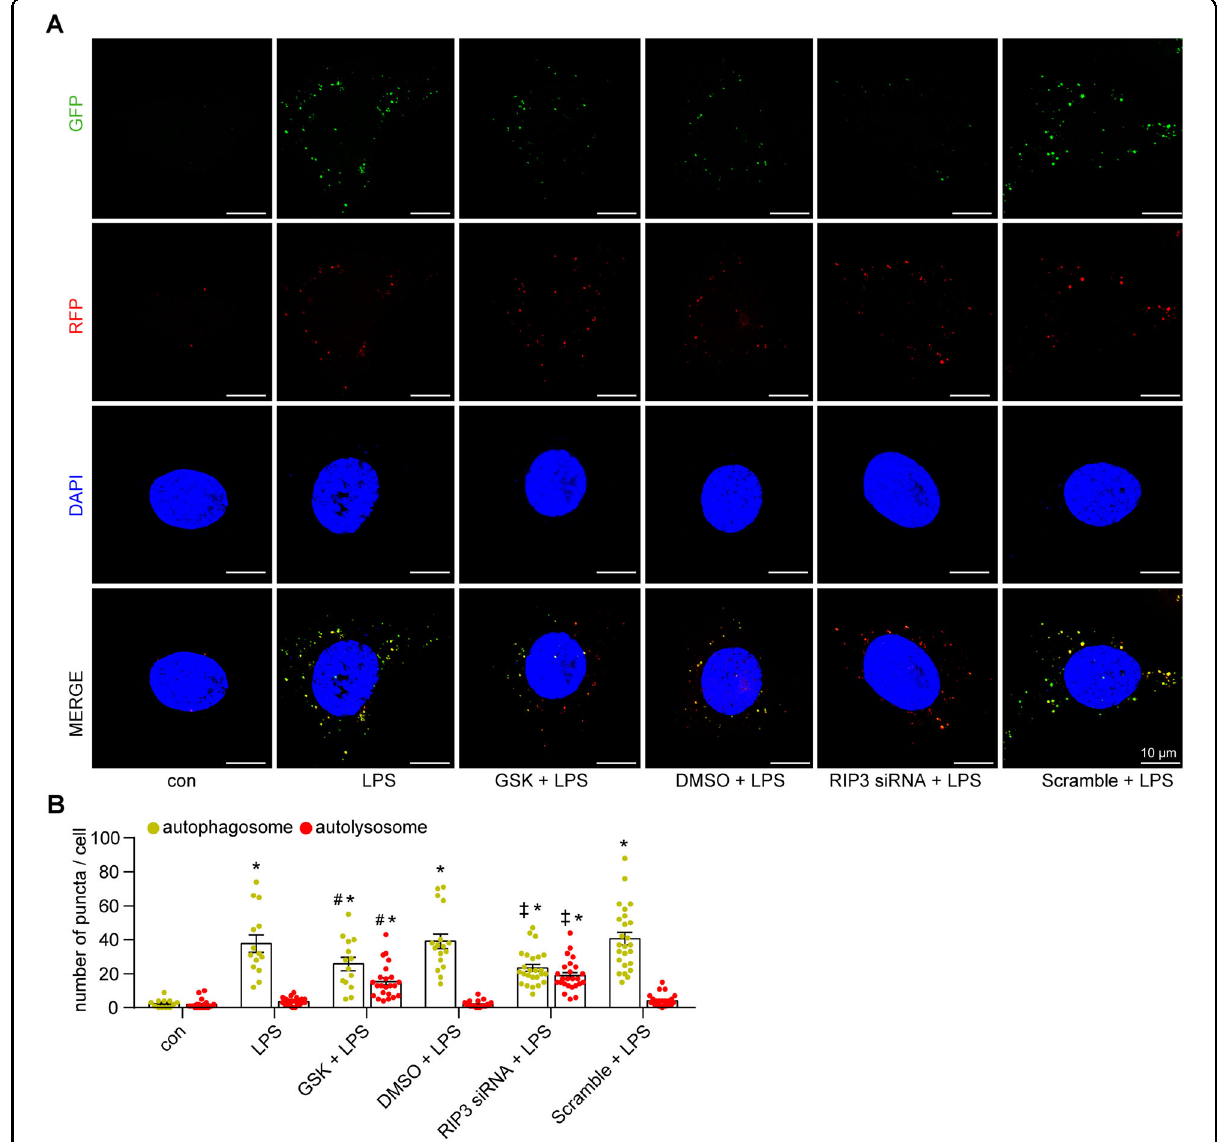
Fig. 4 RIP3 activation suppressed autophagic fl ux in LPS-induced cultured PTECs. A , B Cultured PTECs transfected with mRFP-GFP-LC3 adenovirus and treated as indicated for 24 h. Representative confocal laser scanning microscopy images ( A ) and quantitative analysis ( B ) of autophagosomes (yellow puncta) and autolysosomes (red-only puncta). Few autophagosomes and autolysosomes were observed in the control group. The number of autophagosomes but not autolysosomes was increased in the LPS-treated PTECs (LPS, LPS + DMSO, and LPS + Scramble group). GSK or RIP3 siRNA induced the formation of autolysosomes, whereas it decreased the accumulation of autophagosomes in LPS-induced PTECs ( n = 3 – 4, 21 – 26 cells from each group). * P < 0.05, signi fi cantly different from the control group. # P < 0.05, signi fi cantly different from the DMSO + LPS group. ‡ P < 0.05, signi fi cantly different from the scramble + LPS